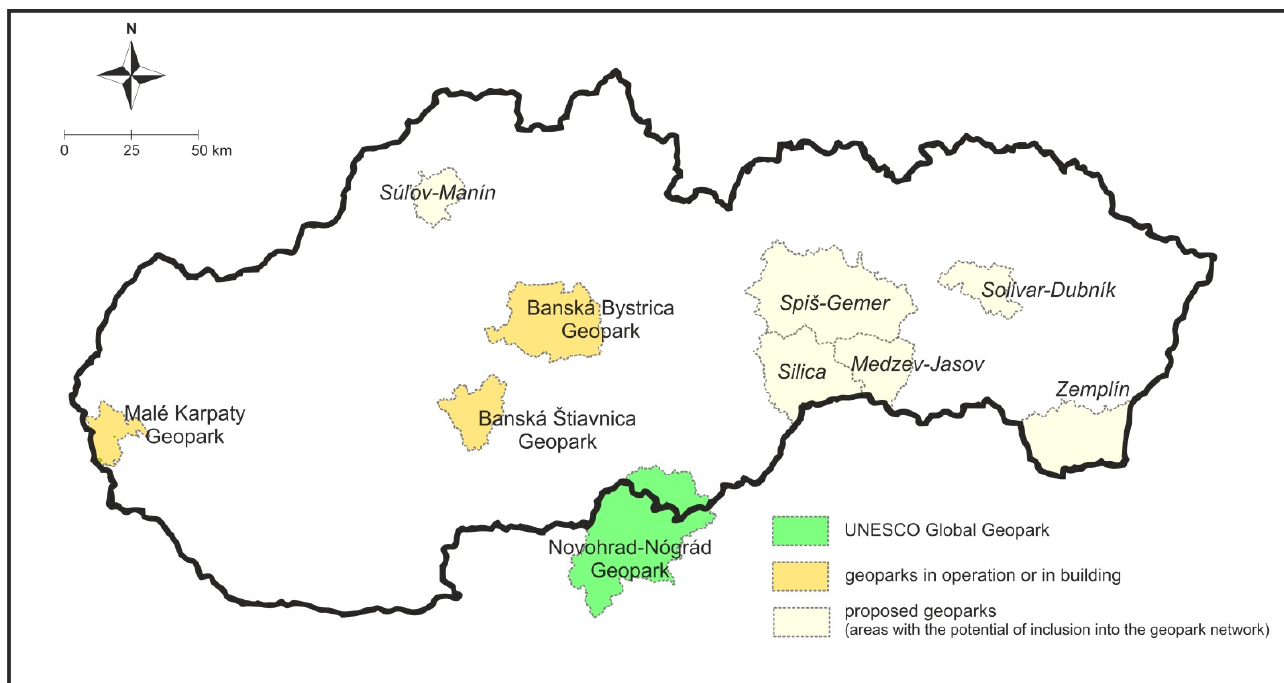
Figure 10. Map of geoparks and areas with the potential of geopark establishment in Slovakia